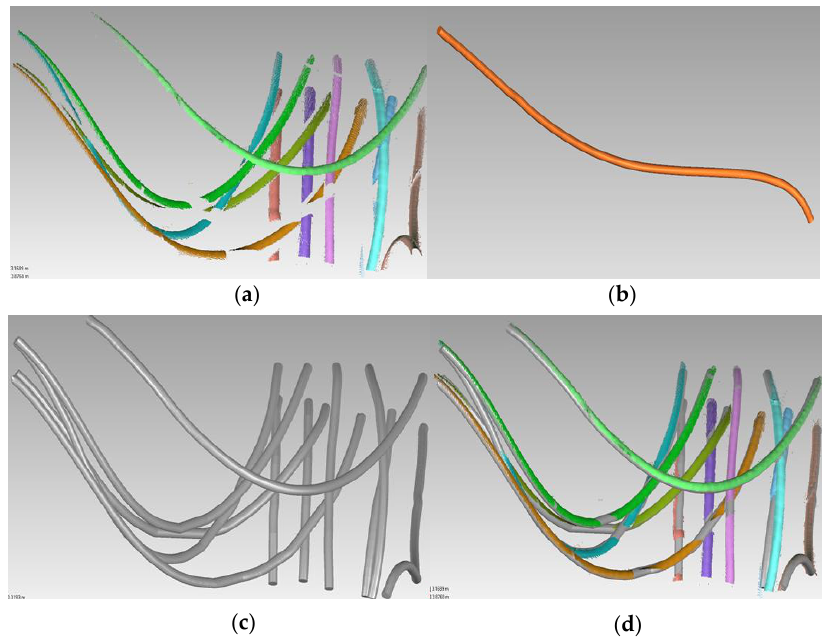
Figure 9. Construction of the cable model. ( a ) Cable point cloud, ( b ) single cable model, ( c ) overall cable model, and ( d ) point cloud and model.